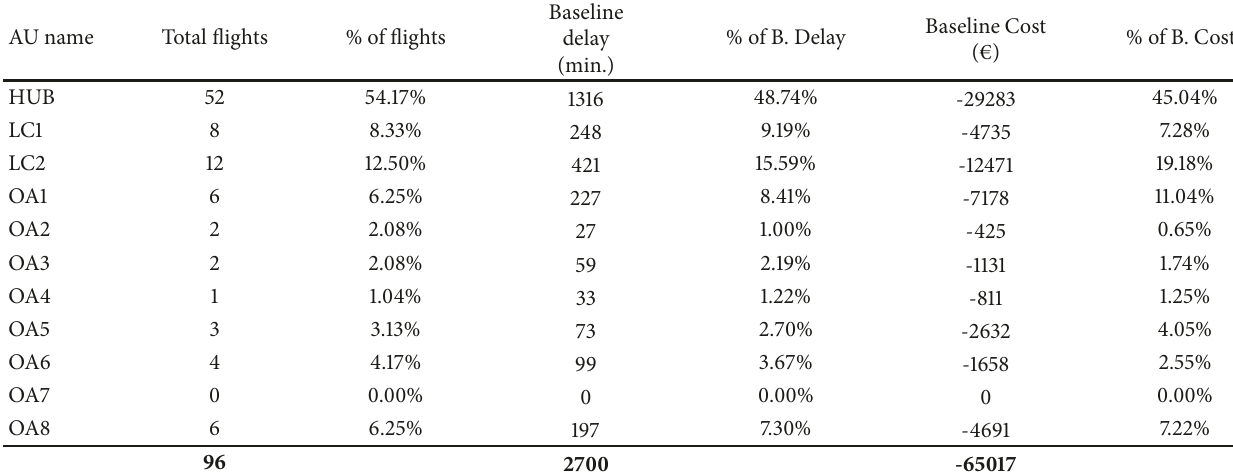
Table 1: Distribution of flights and delay per